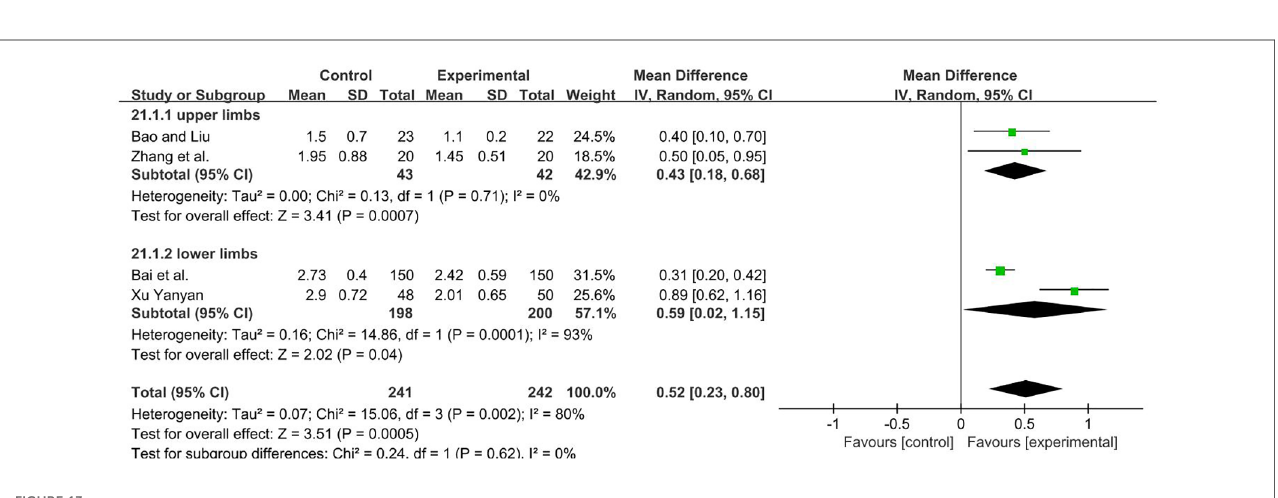
FIGURE 13 Forest plot showing MD (with 95% CI) for MAS of the included studies comparing the experimental and control groups. Note: For the upper limb subgroup, fi xed-effect model [MD=0.43; 95% CI (0.18, 0.68); P <0.001]. For the lower limbs subgroup, random-effect model [MD=0.59; 95% CI (0.02, 1.15); P <0.05]. The analysis results of two subgroups were statistically signi fi